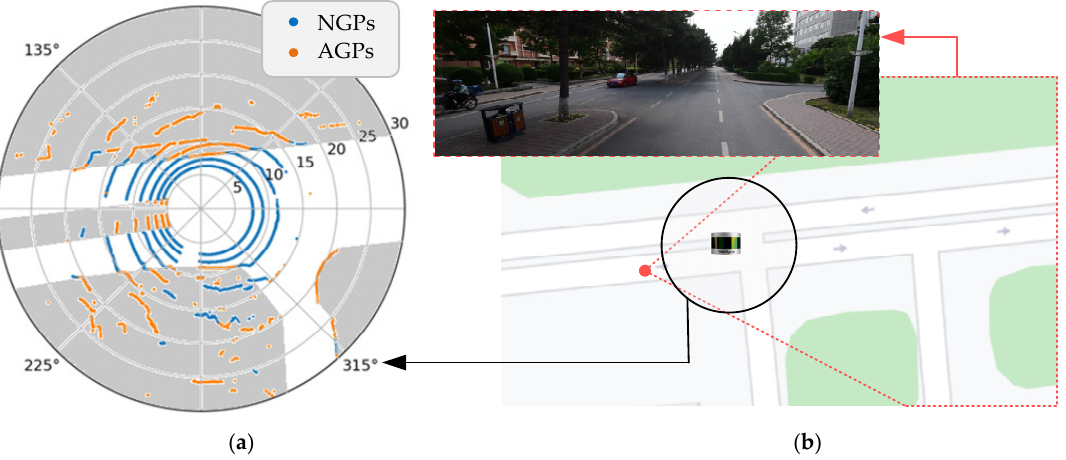
Figure 11. Abnormal ground points (AGPs) and normal ground points (NGPs) separation result. ( a ) The distribution of AGPs and NGPs in the polar coordinate. ( b ) The field scene of the LiDAR sensor scanning.